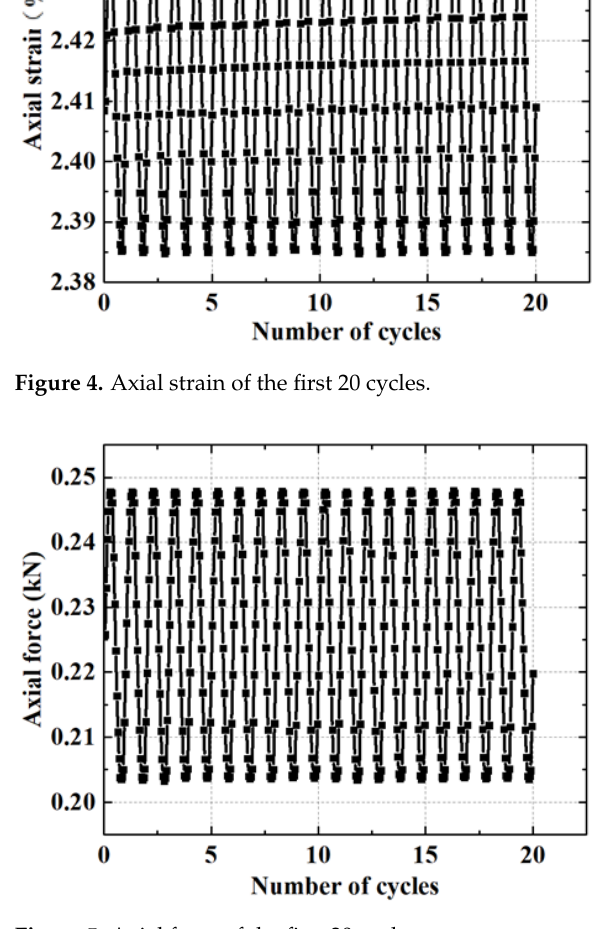
Figure 5. Axial force of the first 20 cycles.